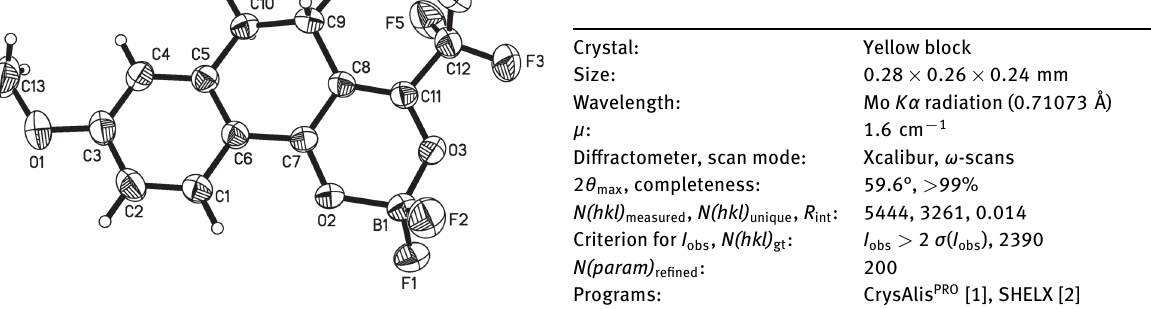
Table 1: Data collection and handling.